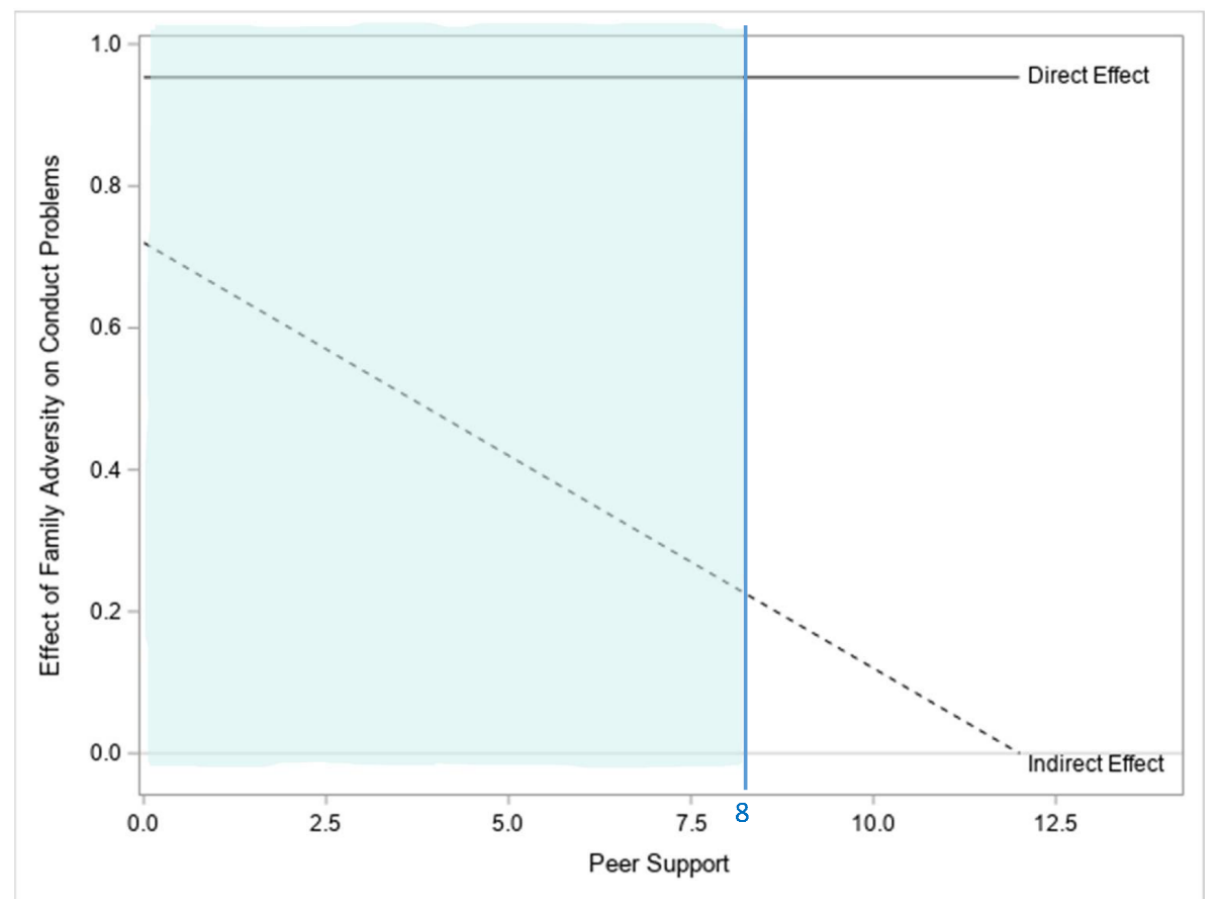
Figure 2. Visual representation of the conditional indirect and the direct effect of family adversity on the conduct problems of CA adolescents, with the indirect effect operating through family caregiving. The blue region to the left of the blue line represents the levels of peer support at which the indirect effect is statistically significant as indicated by bCIs.